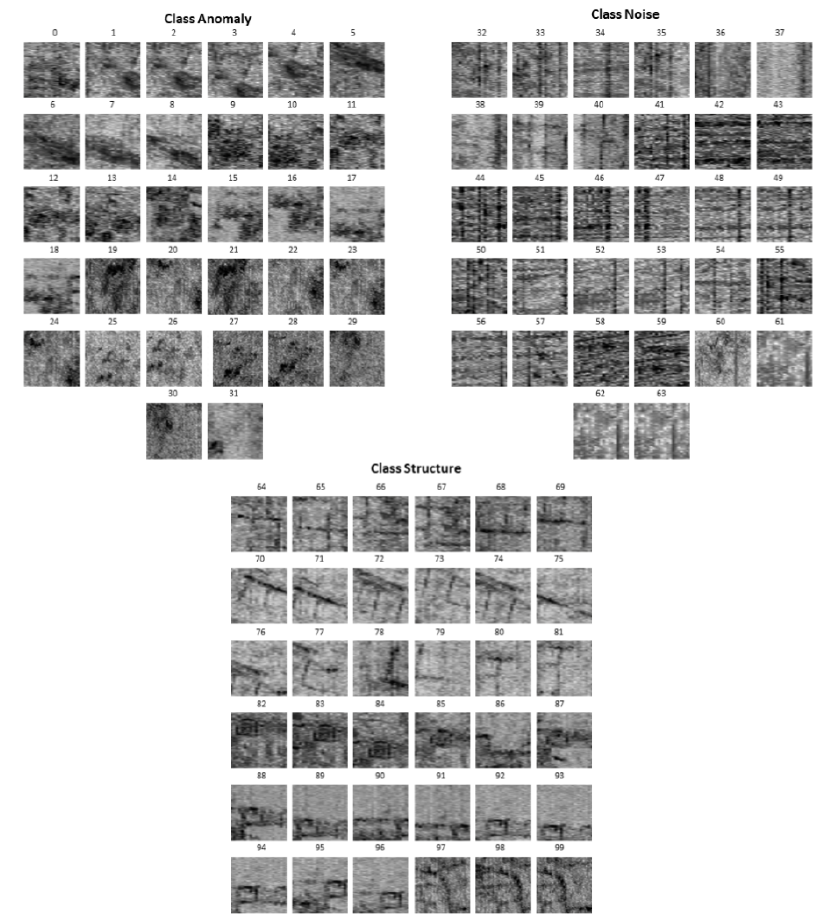
Figure 3. The evaluation set used to test the final models’